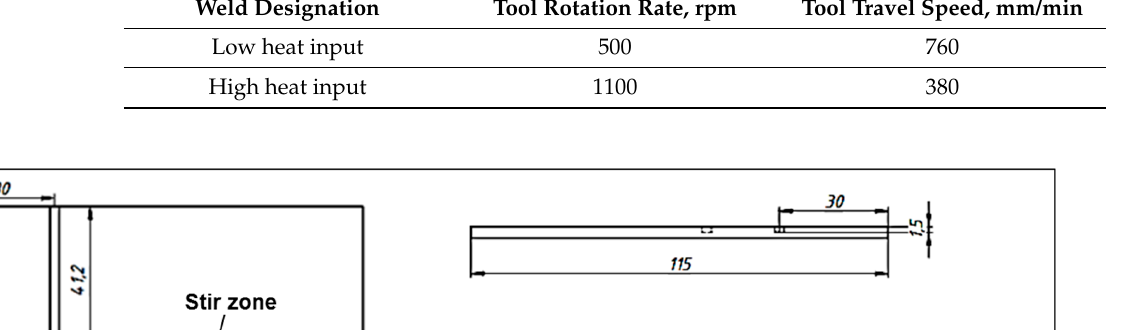
Table 1. FSW conditions applied in this work.